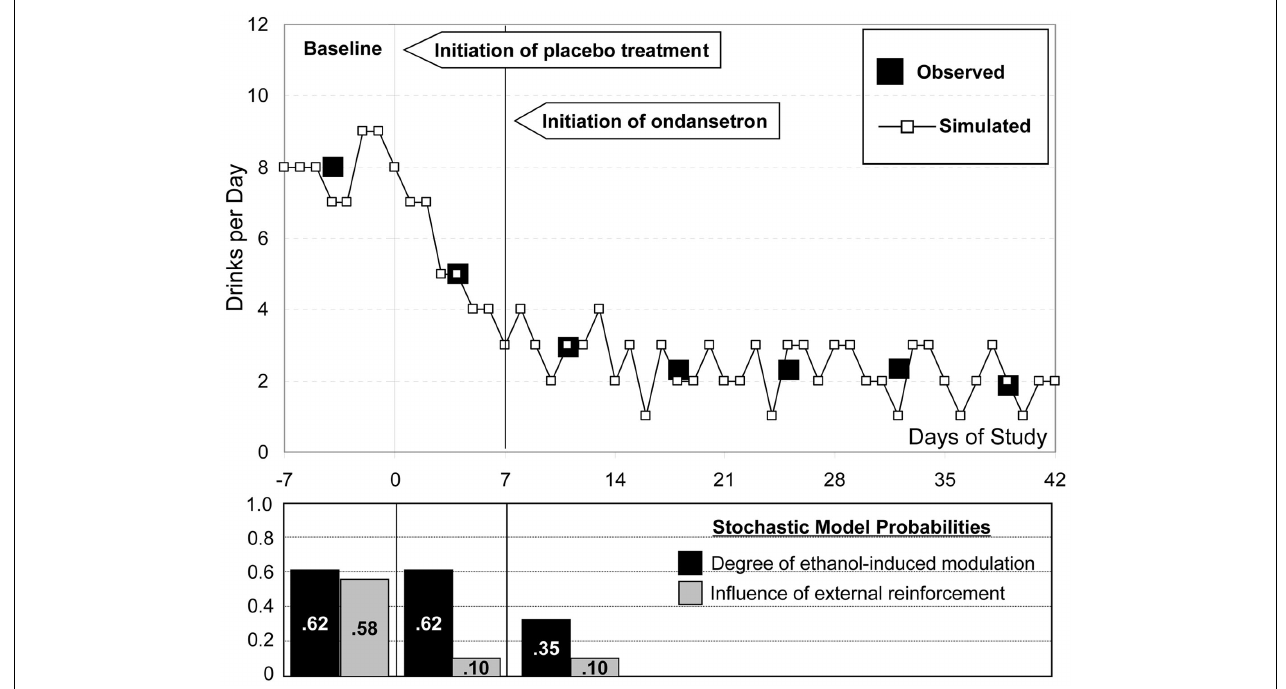
FIGURE 8 | Model-predicted and observed effect of placebo and ondansetron